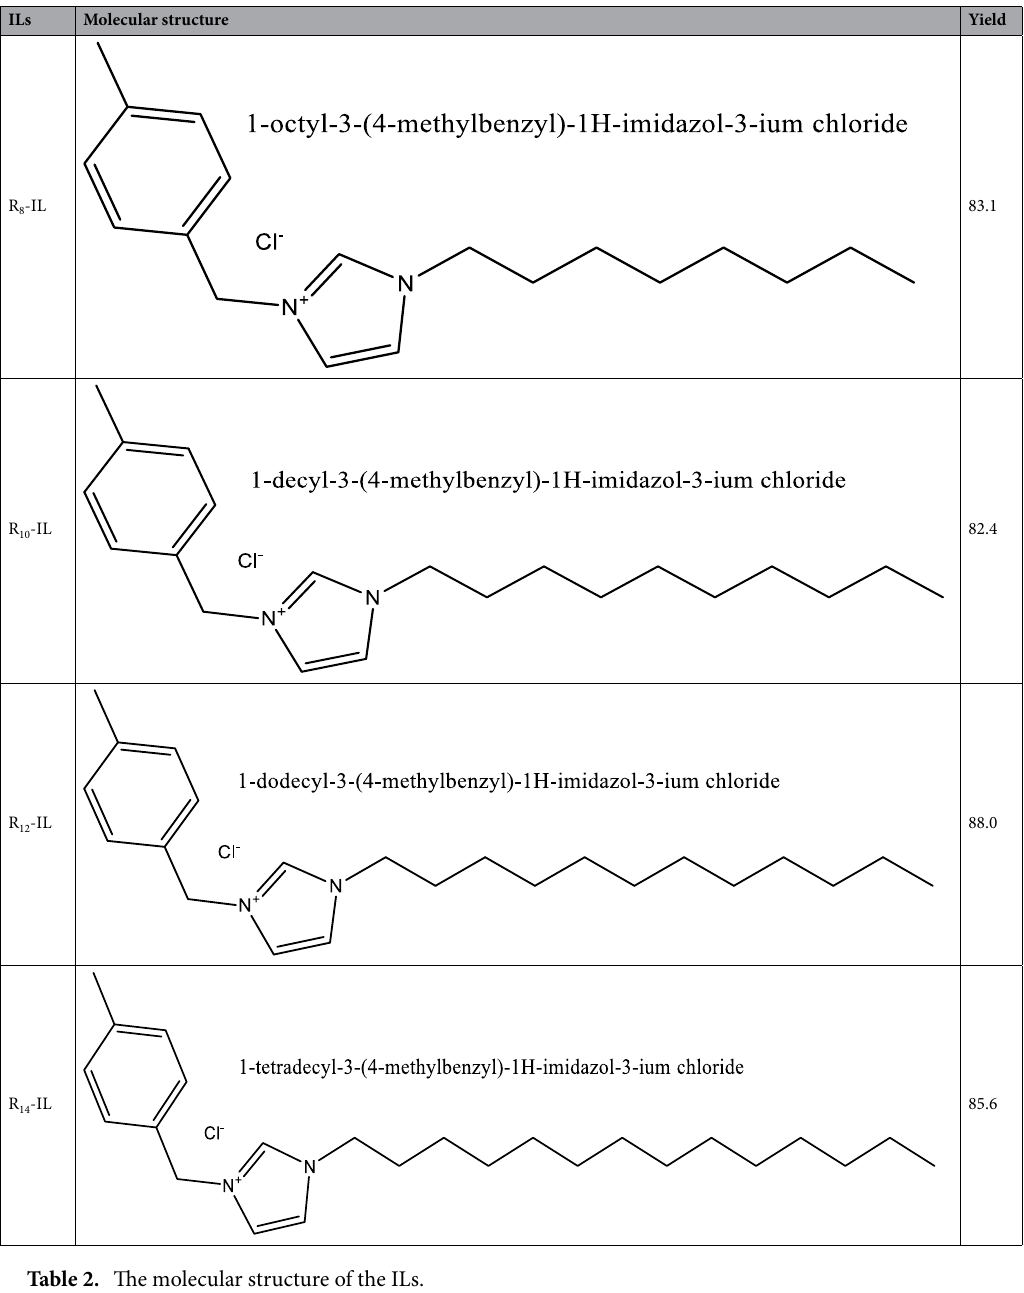
Table 2. The molecular structure of the